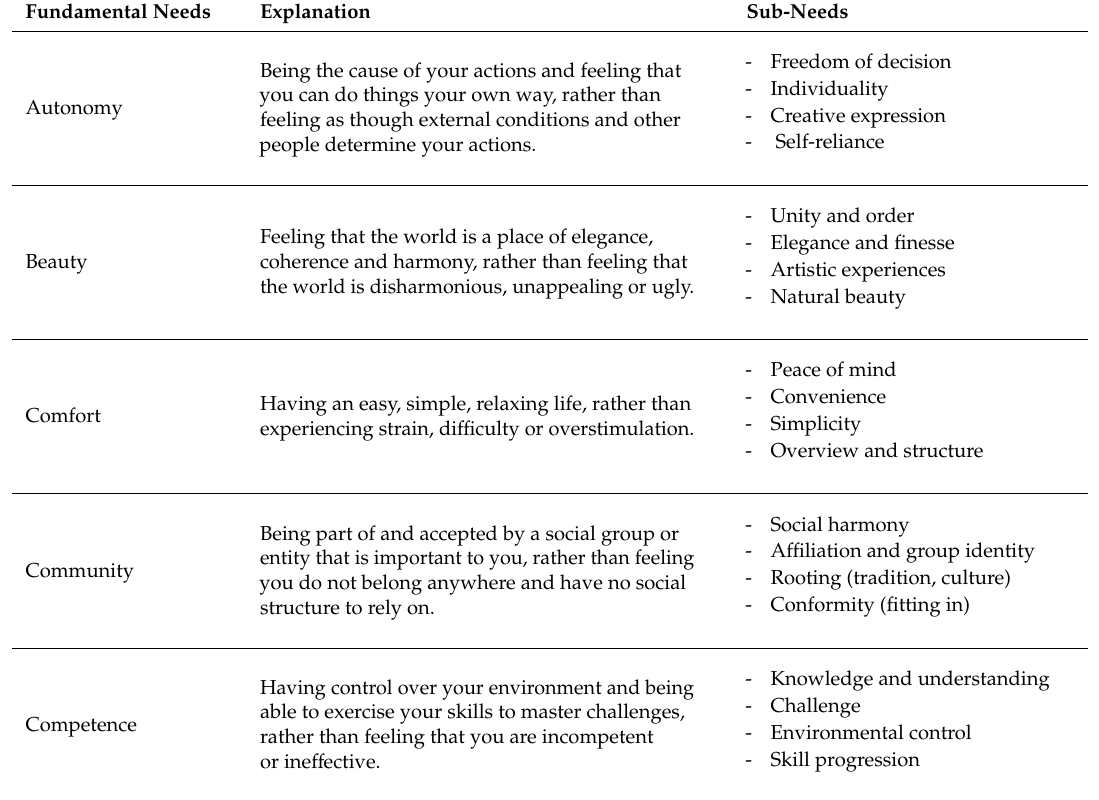
Table 3. An overview of included need concepts can be found in Appendix A. Table 3. Thirteen fundamental psychological needs and 52